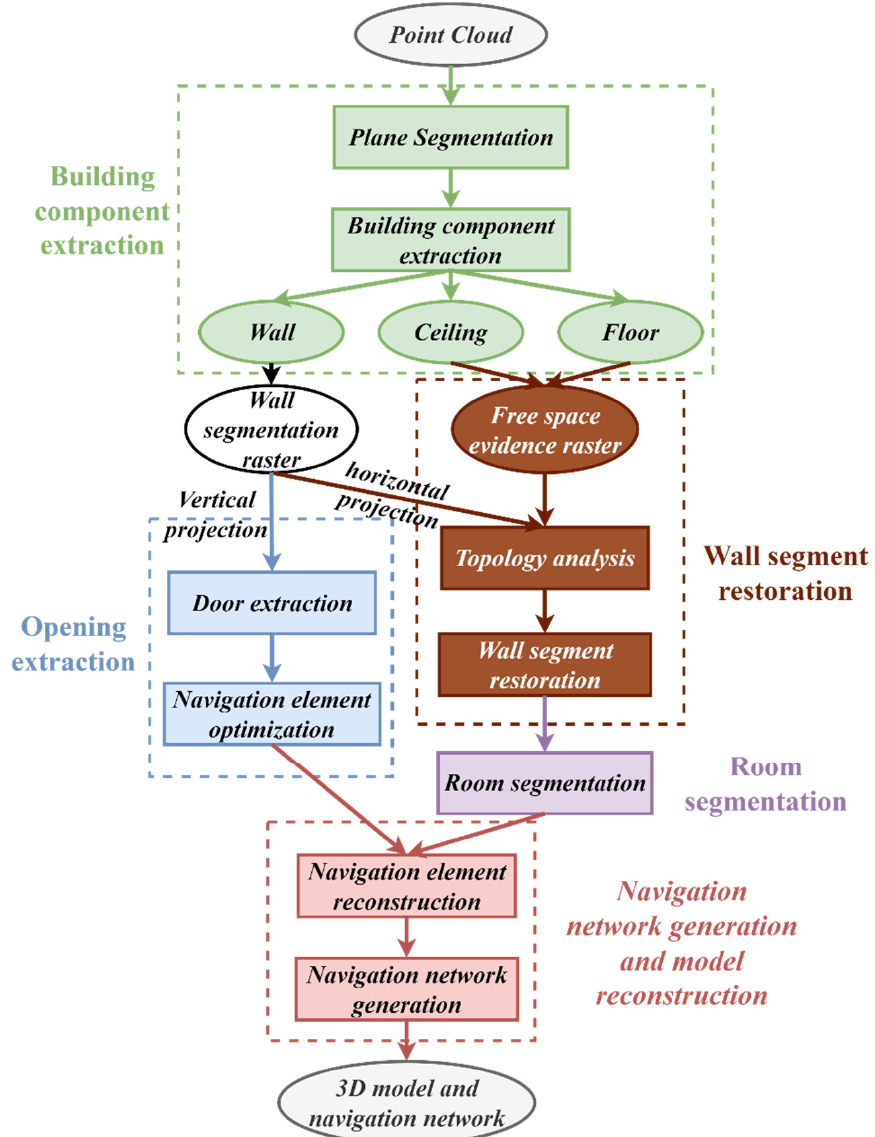
Figure 3. Flowchart for reconstruction of navigation elements and network.